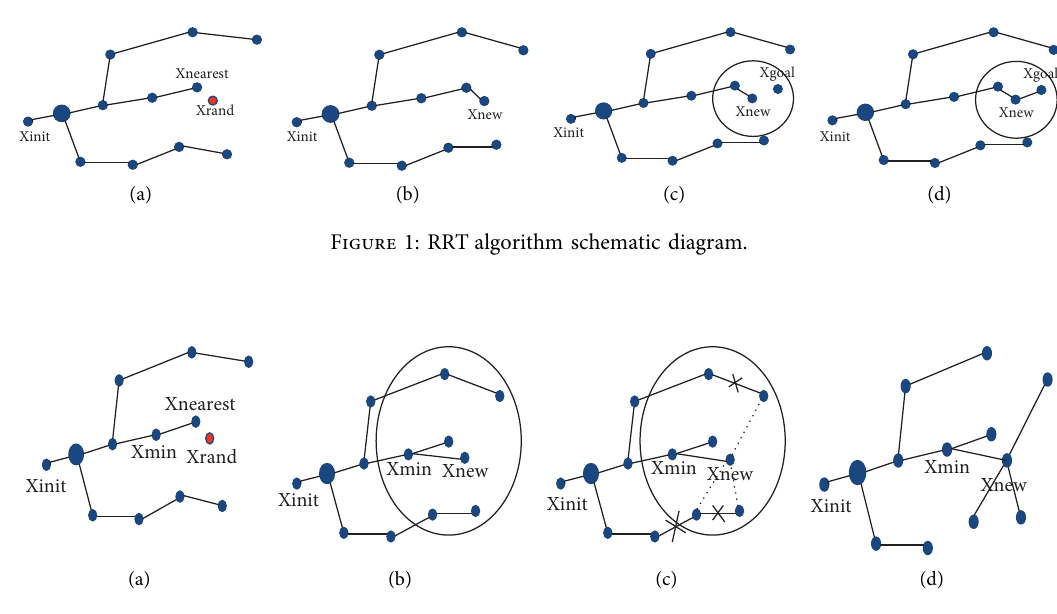
Figure 2: The informed-RRT ∗ algorithm reselects the parent node and rewiring schematic diagram. (a) Extended random tree. (b) Reselecting parent node. (c) Replanning. (d) Replanned.